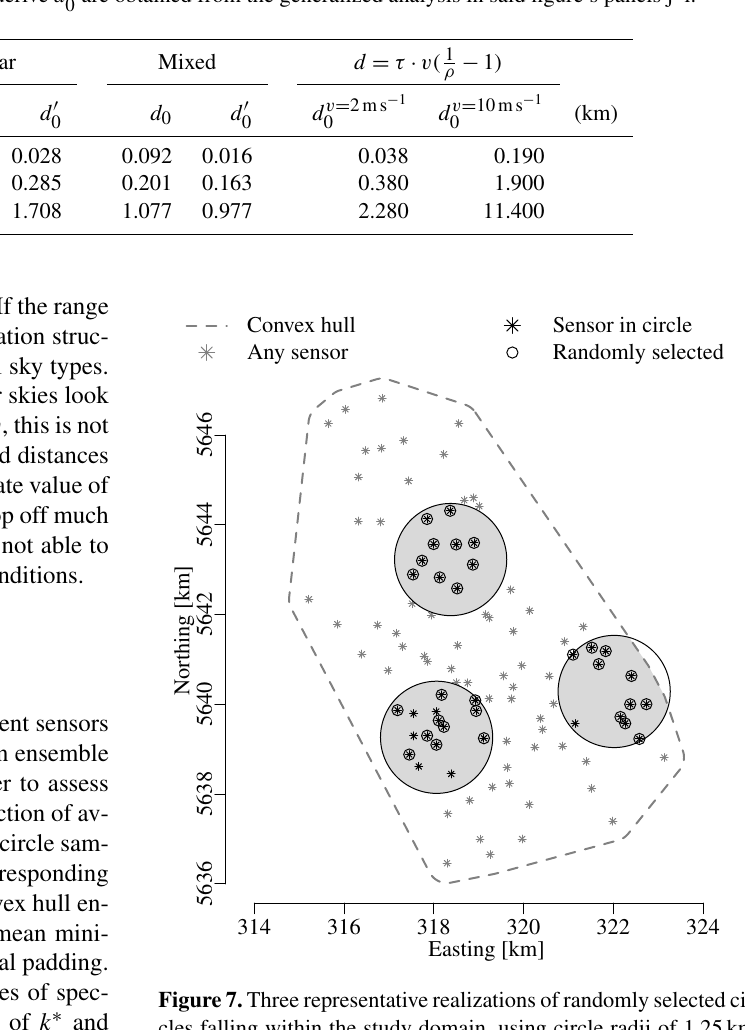
Table 2. Increment decorrelation length scales d 0 and effective decorrelation length scales d from Fig. 6. Scaled decorrelation distances ˆ d 0 used to derive d (cid:48)